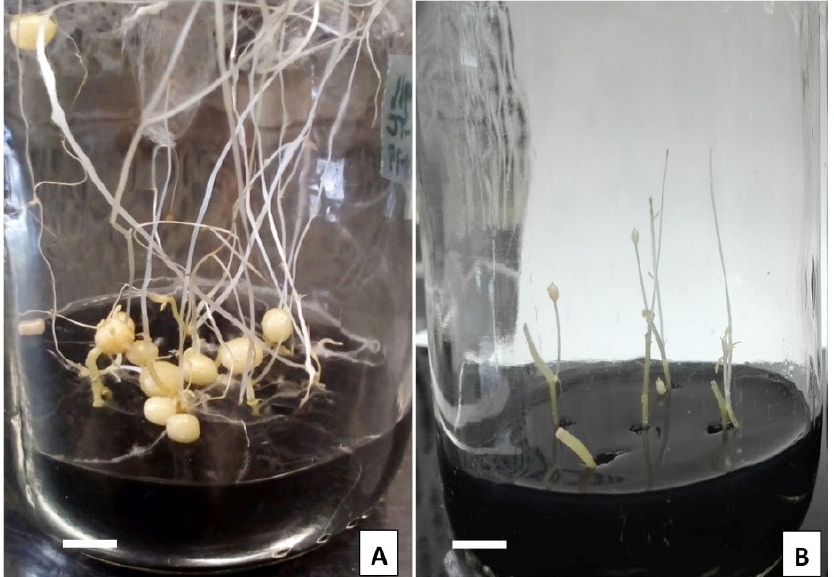
Figure 1. ( A ). Microtuber development of potato S. tuberosum cv. Alpha in medium with 8% sucrose, 6 g/L gelrite and activated charcoal after four weeks of incubation in darkness. ( B ). Shoot explants of potato in medium with low content of sucrose (1%), gelrite 3 g/L and activated charcoal after four weeks of incubation in darkness. Bar represents 1 cm.